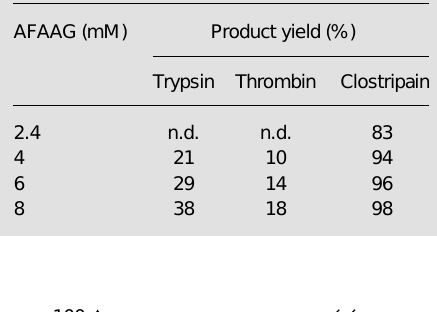
Figure 6 - Course of the clostri- pain-catalyzed (3+5) fragment condensation of Boc-Phe-Gly- Gly-OGp and H-Ala-Phe-Ala-Ala- Gly-OH (27). Boc-Phe-Gly-Gly- OGp (triangles); Boc-Phe-Gly- Gly-Ala-Phe-Ala-Ala-Gly-OH (squares); Boc-Phe-Gly-Gly-OH (circles). Conditions: 50